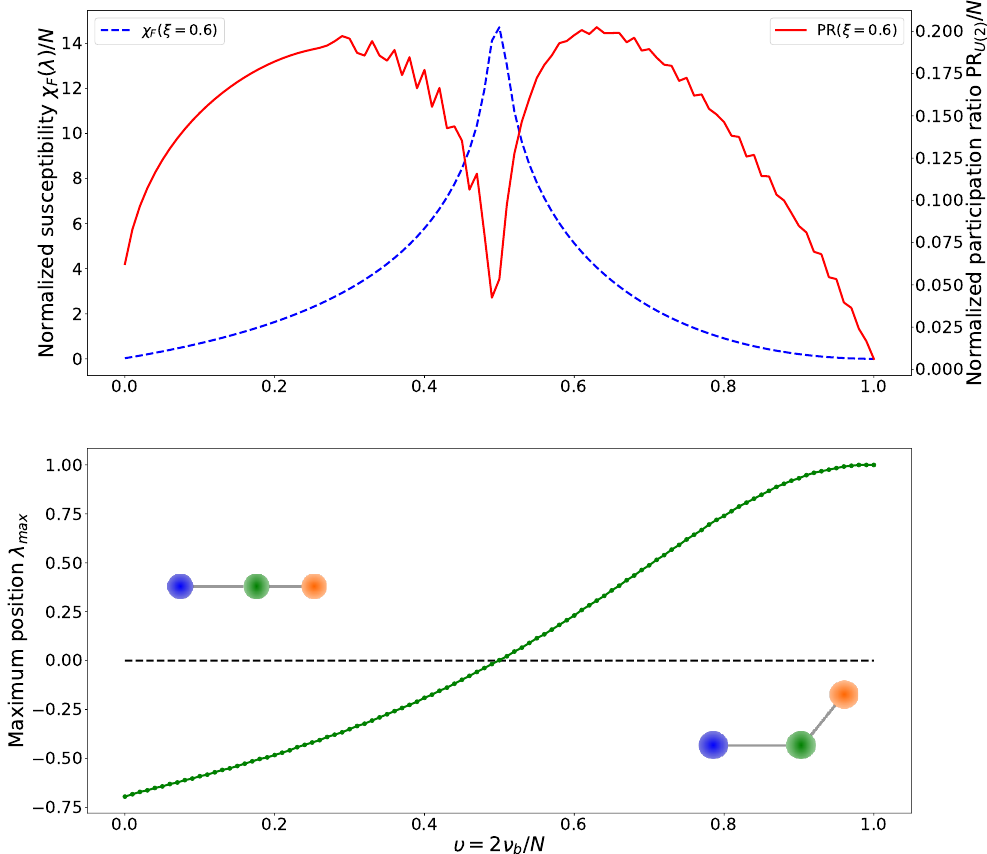
Figure 2: All panels: Results for the 2DVM model Hamiltonian (10) with ξ = 0.6 and N = 200. Upper panel: PR (red solid line, right ordinate axis scale) and QFS (blue dashed line, left ordinate axis scale) for the λ = 0 eigenstates. Lower panel: Position of the QFS maxima, λ , for each eigenstate versus the normalized bending max / N . The black dashed line marks the λ = 0 quantum number 2 ν b